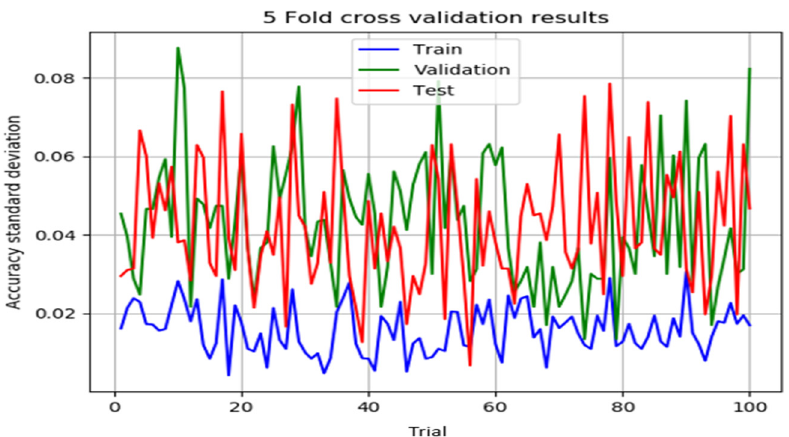
Figure 2. Typical percentage deviation of patterns correctly classified for 100 algorithms using k -fold cross-validation ( k = 5) tests.